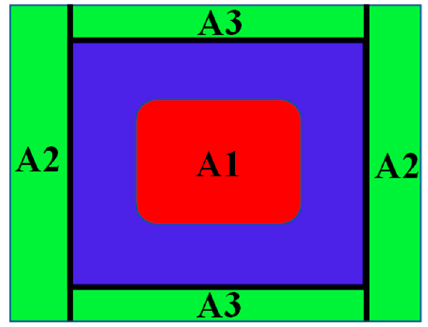
Figure 8. Prediction of magnetic flux density in the fluid gap.